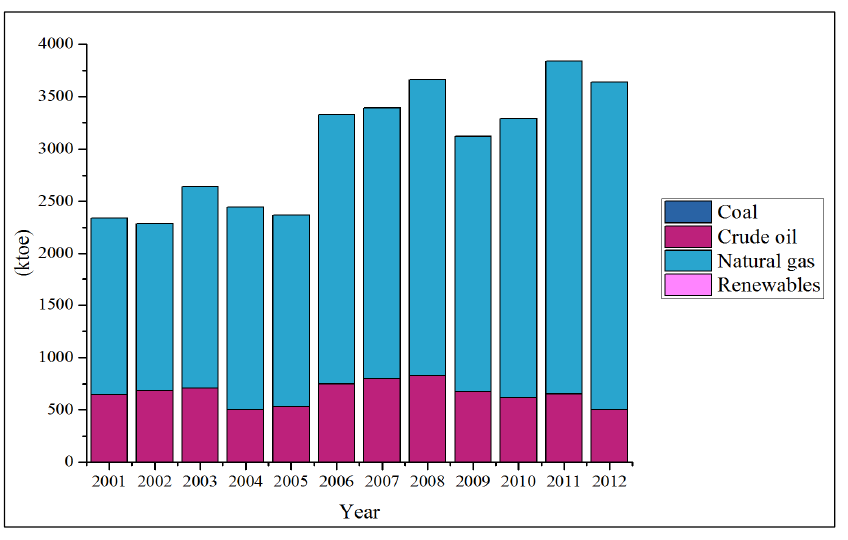
Figure 1. Brunei: primary energy mix.